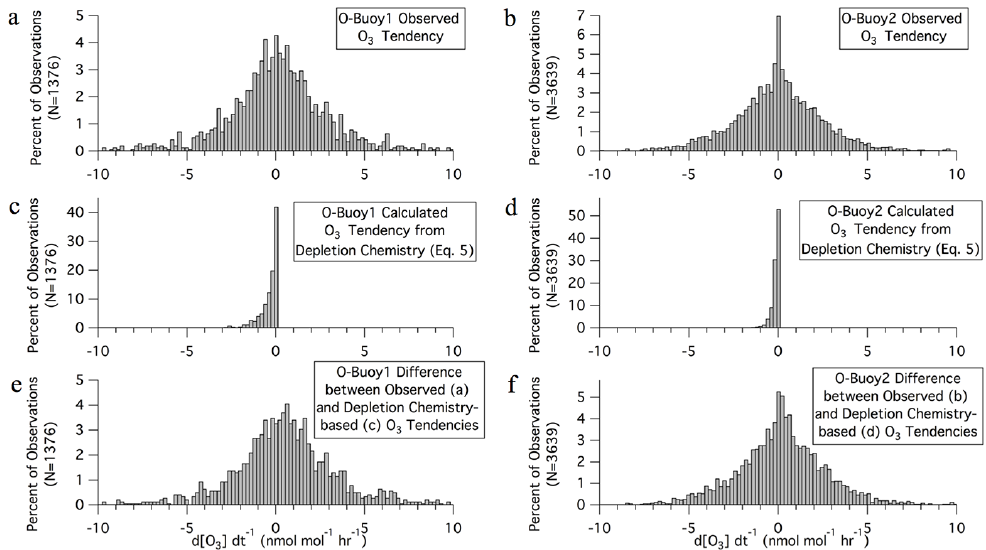
Figure 7. Histogram of the O 3 tendency for observations from O-Buoy1 at Barrow, AK (a, c, e) , and O-Buoy2 in the Beaufort Sea (b, d, f) . (a, b) show the distributions of observed O 3 tendencies between consecutive BrO measurement points. Middle plots (c, d) represent the O 3 tendency distribution based on the depletion chemistry accounted for by Eq. (5). (e, f) result from the difference of the observed O 3 tendency (a, b) and the contributions of the chemistry accounted for by Eq. (5) (c, d) .